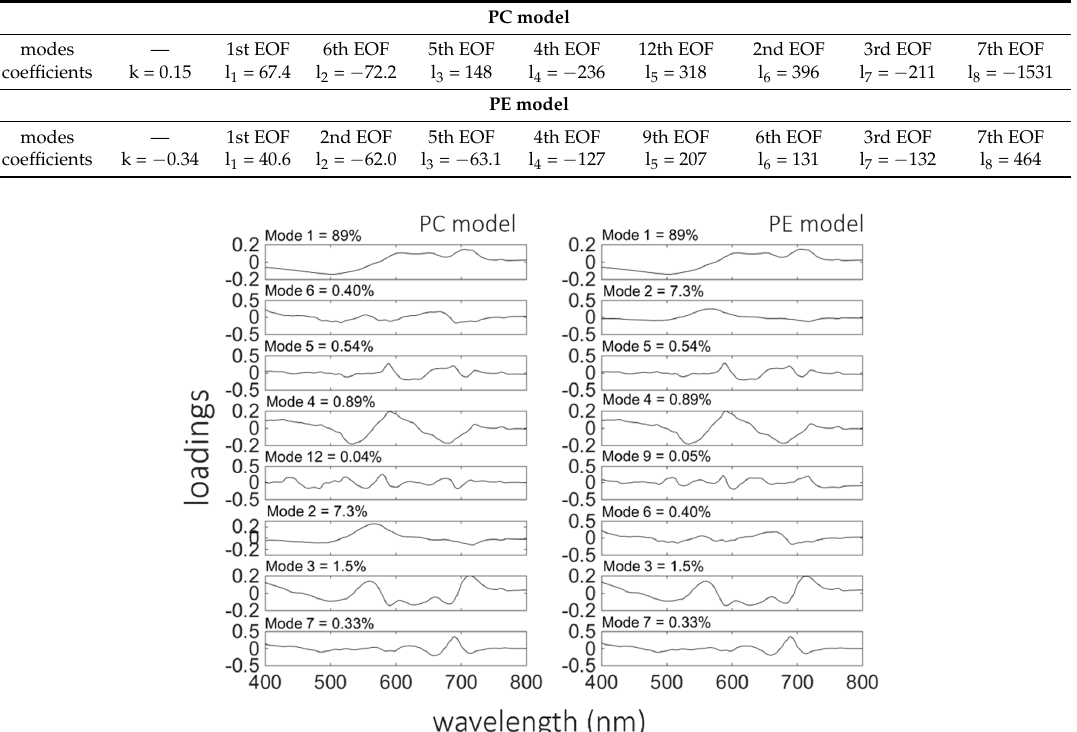
Figure 8. EOF loadings versus wavelength for the PC ( left panel ) and PE ( right panel ) models showing percent contribution to the total variance in R rs . Modes are shown in order of being included in the model with increasing p - value.